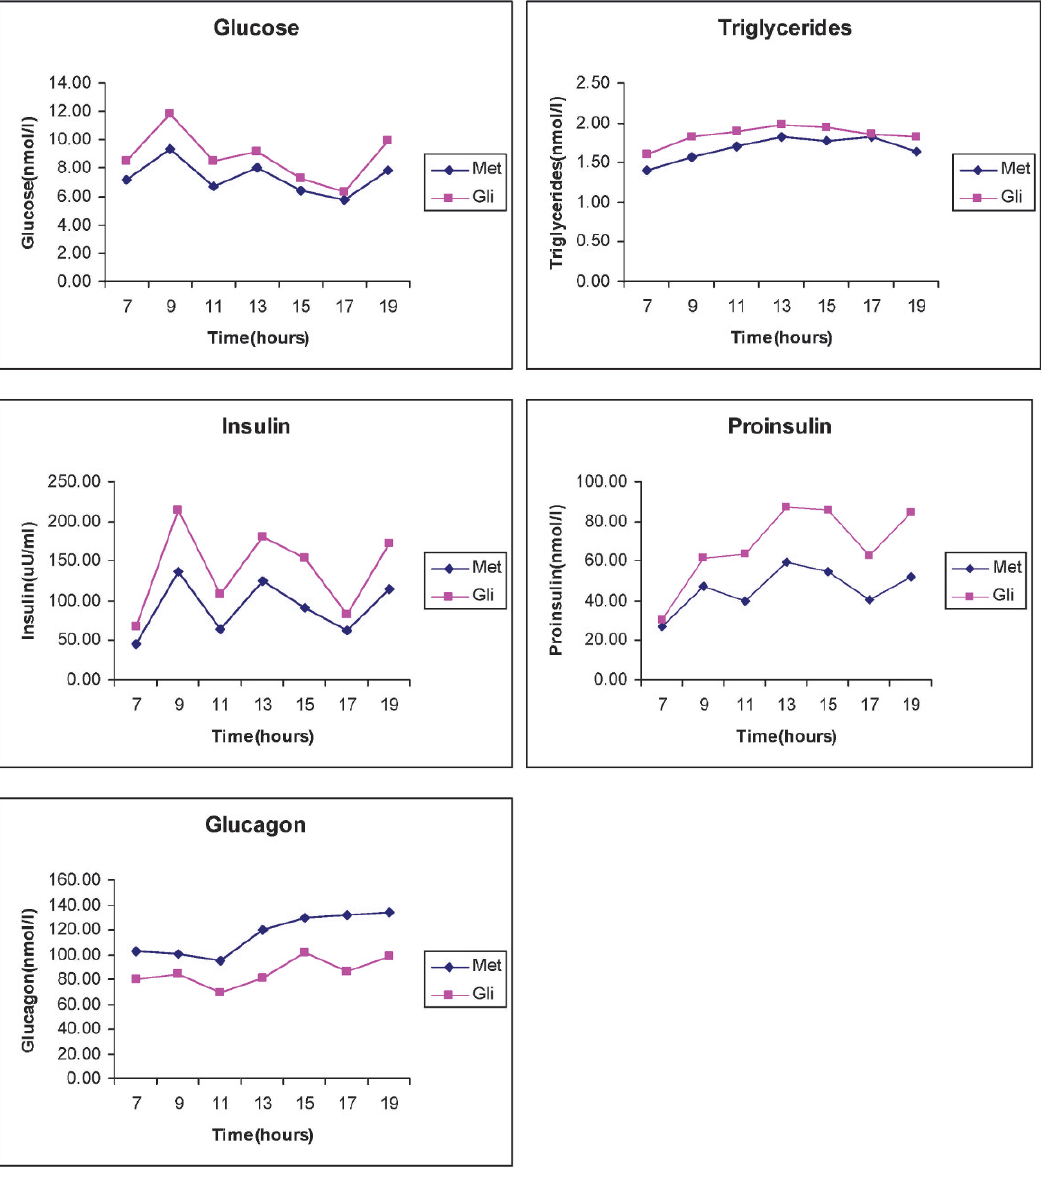
Figure 1 - 12-h metabolic profiles of glucose, triglyceride, insulin, proinsulin and glucagon levels. Mean levels are